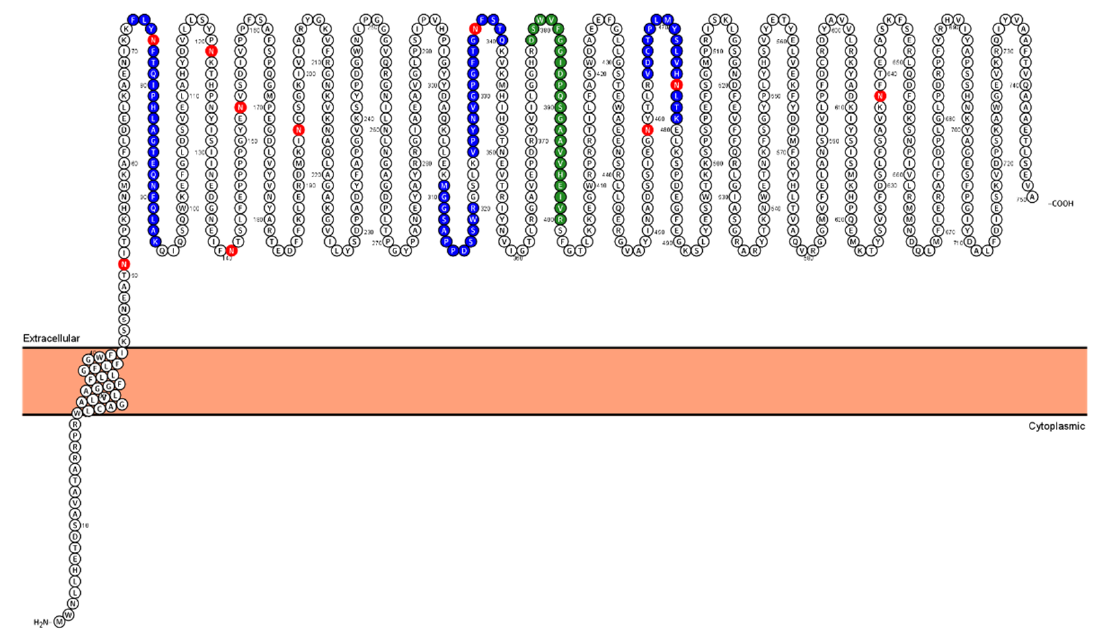
Figure 3. Topology of PSMA with mapped identified peptides. The 5 identified peptides were mapped to the PSMA sequence. The 4 peptides identified by the glycocapture methods N-glyco-FASP and SPEG are marked in blue, and the single peptide found by the standard SDC-trypsin approach is shown in green. The red Asn residues are N-glycosylation sites annotated in UniProt. The visualization was created by Protter software [14].